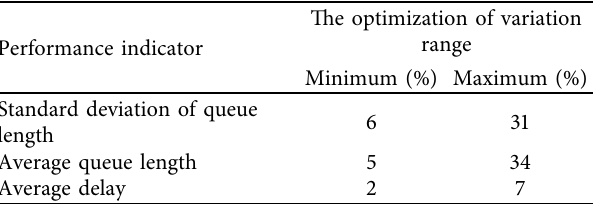
Figure 8: The optimization of fluctuation range in different performance indicators. (a) The optimization of variation range in standard deviation of queue length. (b) The optimization of variation range in average queue length. (c) The optimization of variation range in average delay. Table 2: The minimum and maximum optimized percentage of variation